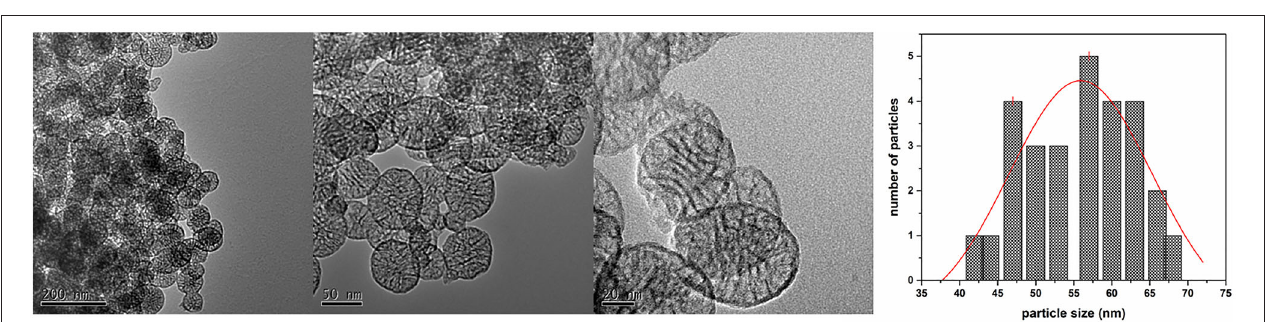
FIGURE 3 | TEM micrographs at different magnification of the obtained MSN and graph of particle size